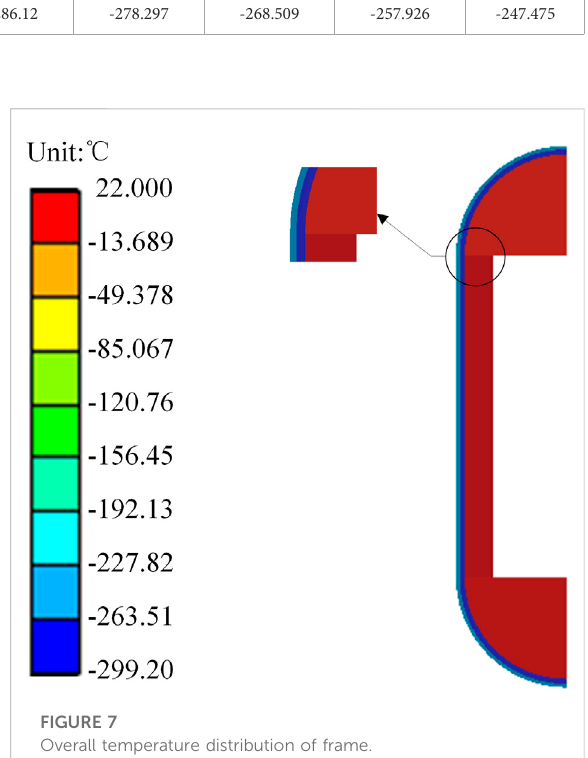
FIGURE 7 Overall temperature distribution of